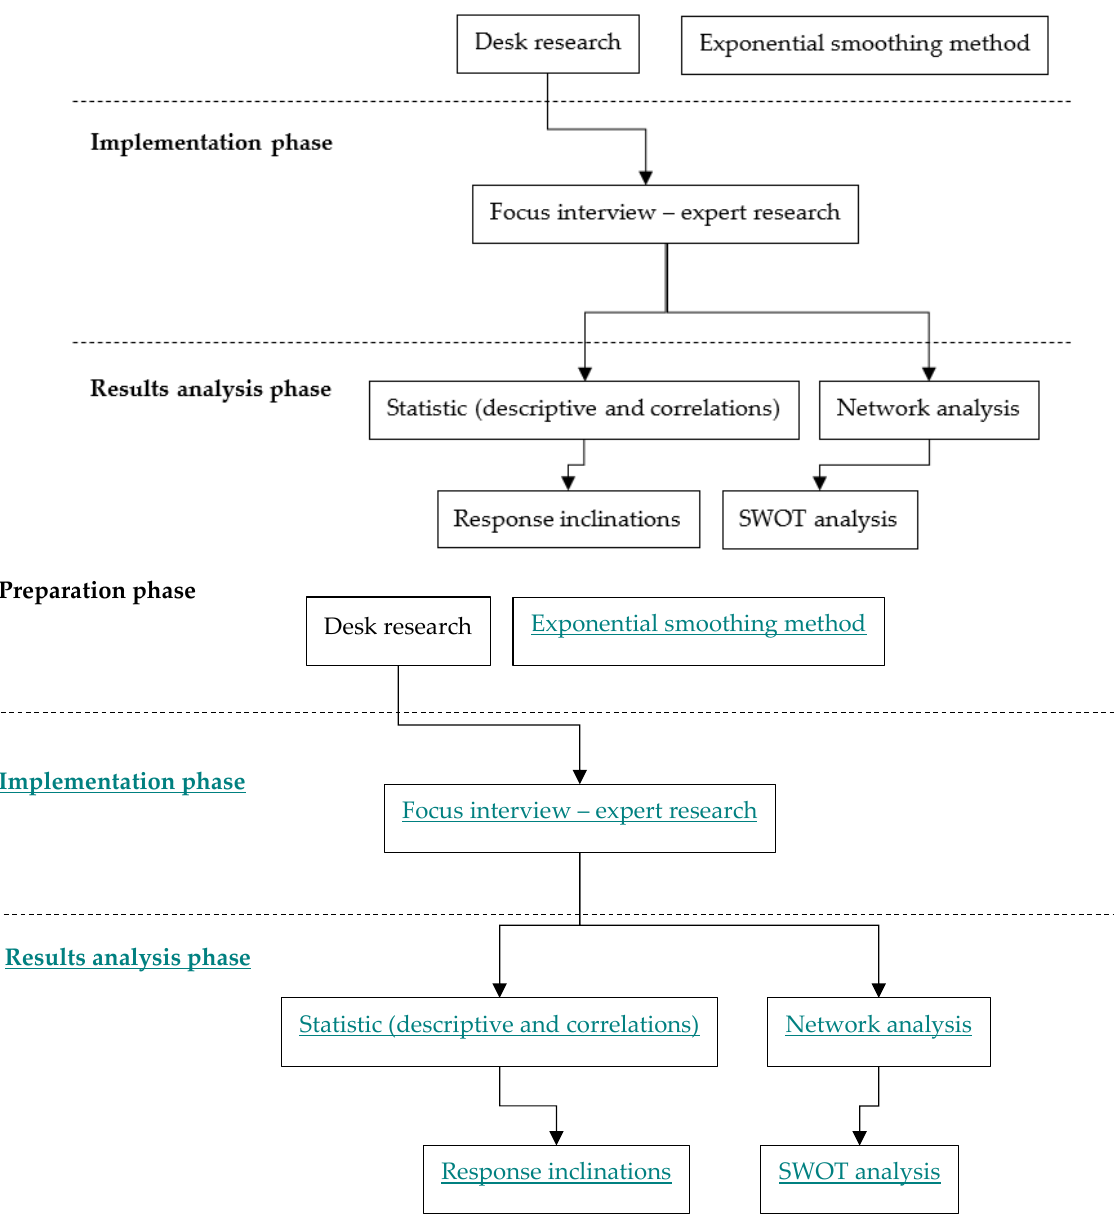
Figure 5. The scheme of the author’s research. Source: Own study.